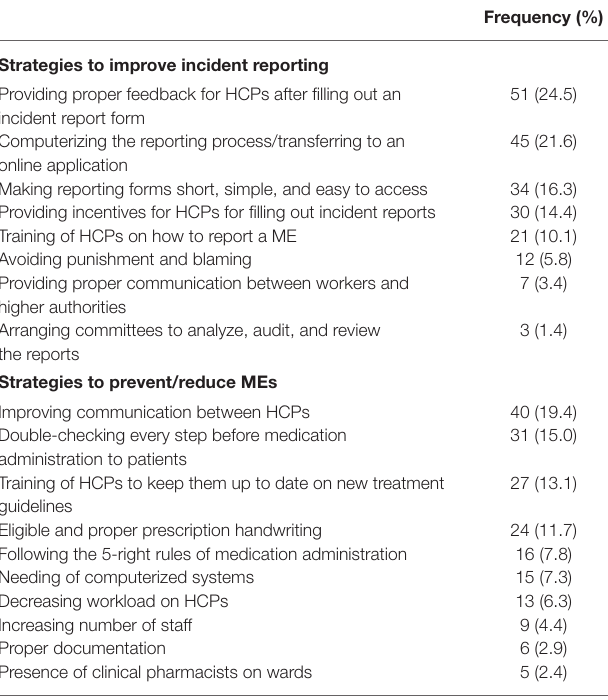
TABLE 9 | Strategies to prevent MEs and improve incident reporting. TABLE 10 | Mean perception scores toward MEs reporting stratified by demographics of the